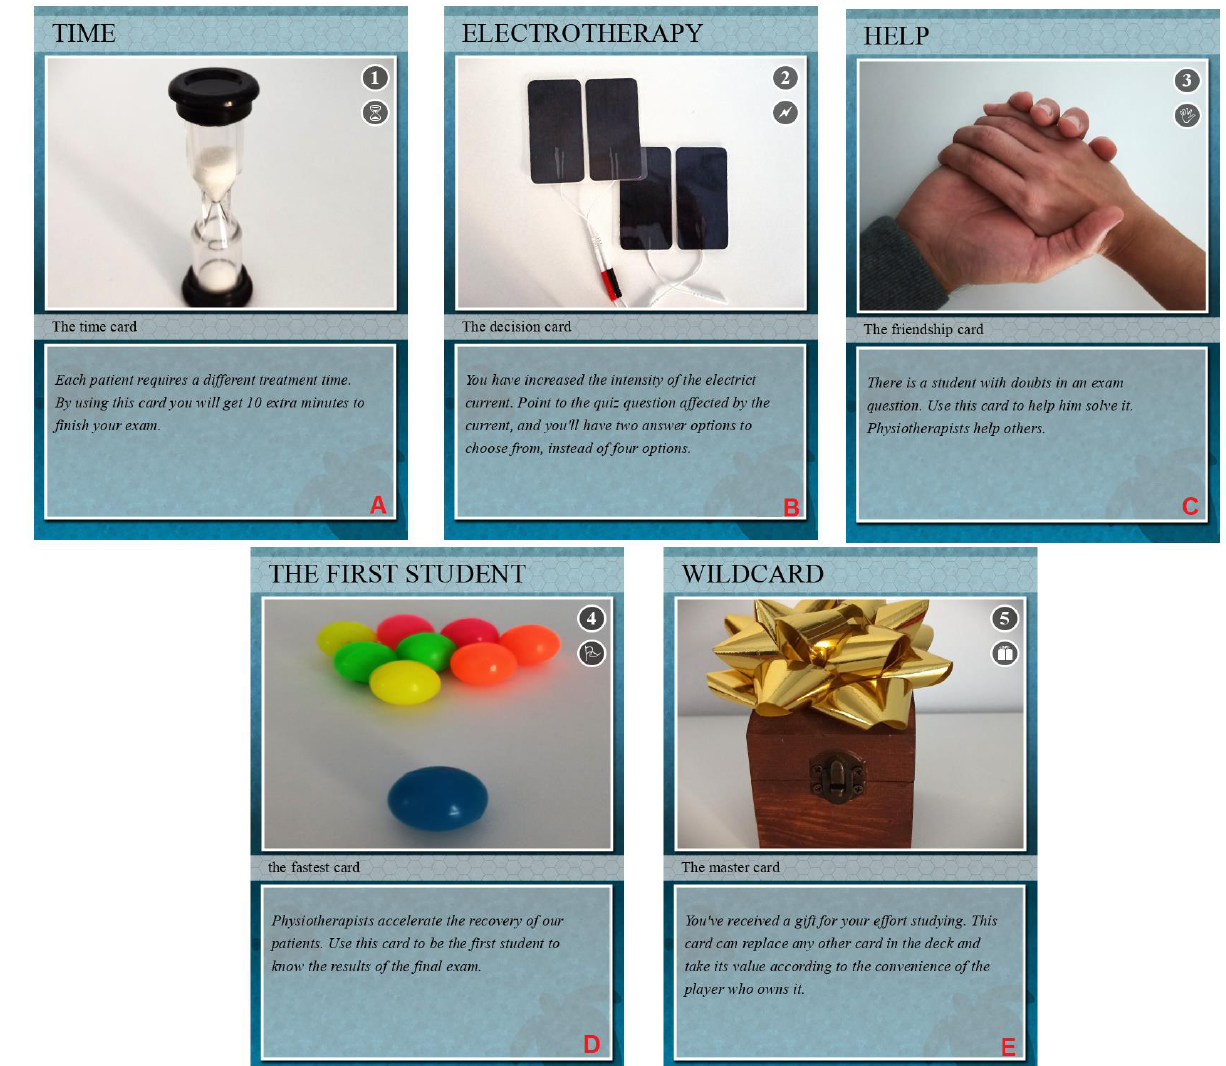
Figure 2. Reward-based playing cards using in this PTIP: ( A ) the time card; ( B ) the decision card; ( C ) the friendship card; ( D ) the fastest card; ( E ) the master card.